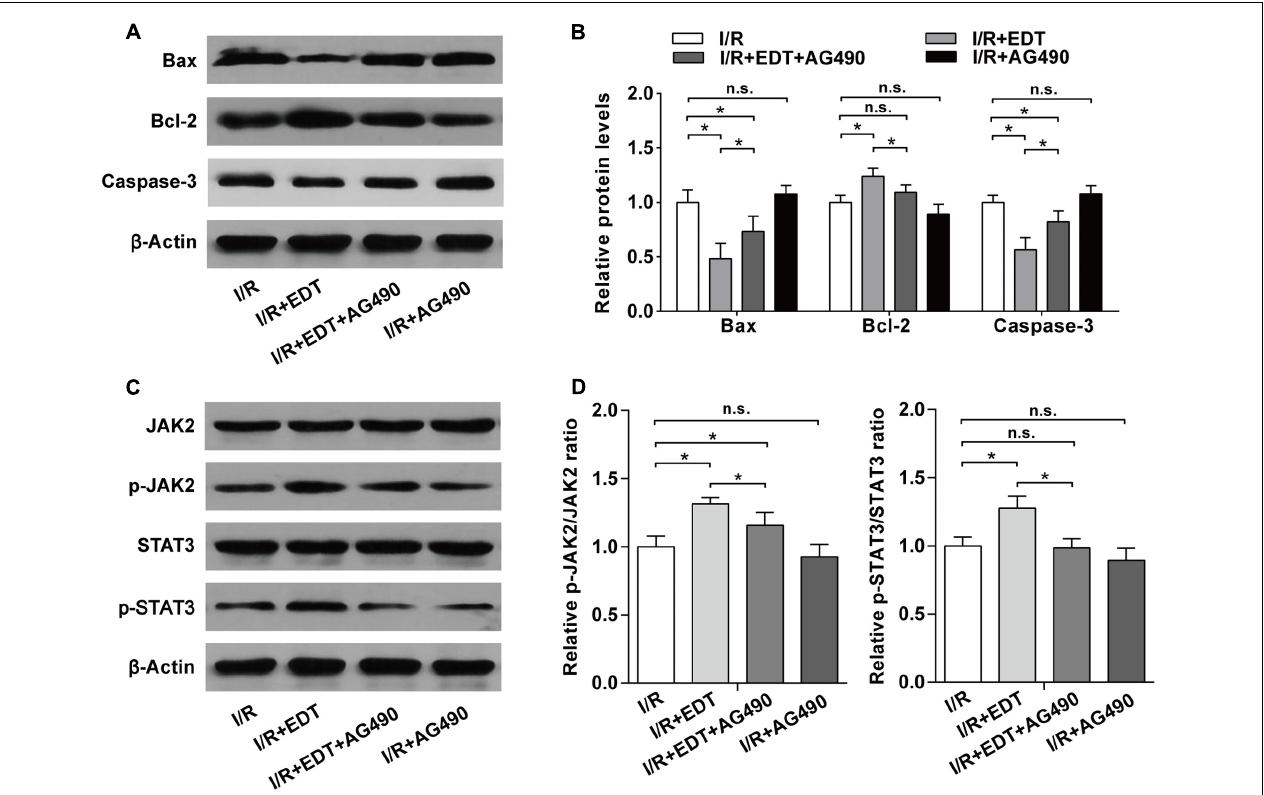
FIGURE 7 | AG490 abolishes the effect of EDT on the expression of apoptosis-related proteins and the activation of JAK2 in myocardium I/R injury. (A) The protein levels of Bax, Bcl-2 and cleaved Caspase-3 in cardiac tissues were measured by western blot. (B) Statistical analysis of Bax, Bcl-2 and cleaved Caspase-3 protein levels in cardiac tissues from the indicated groups. (C) The protein levels of JAK2, p-JAK2, STAT3, and p-STAT3 in cardiac tissues were measured by western blot. (D) Statistical analysis of p-JAK2/JAK2 ratio and p-STAT3/STAT3 ratio in cardiac tissues from the indicated groups. n = 4 per group. The protein ratios were normalized to the values of the control group. All data are the mean ± SD. ∗ P <